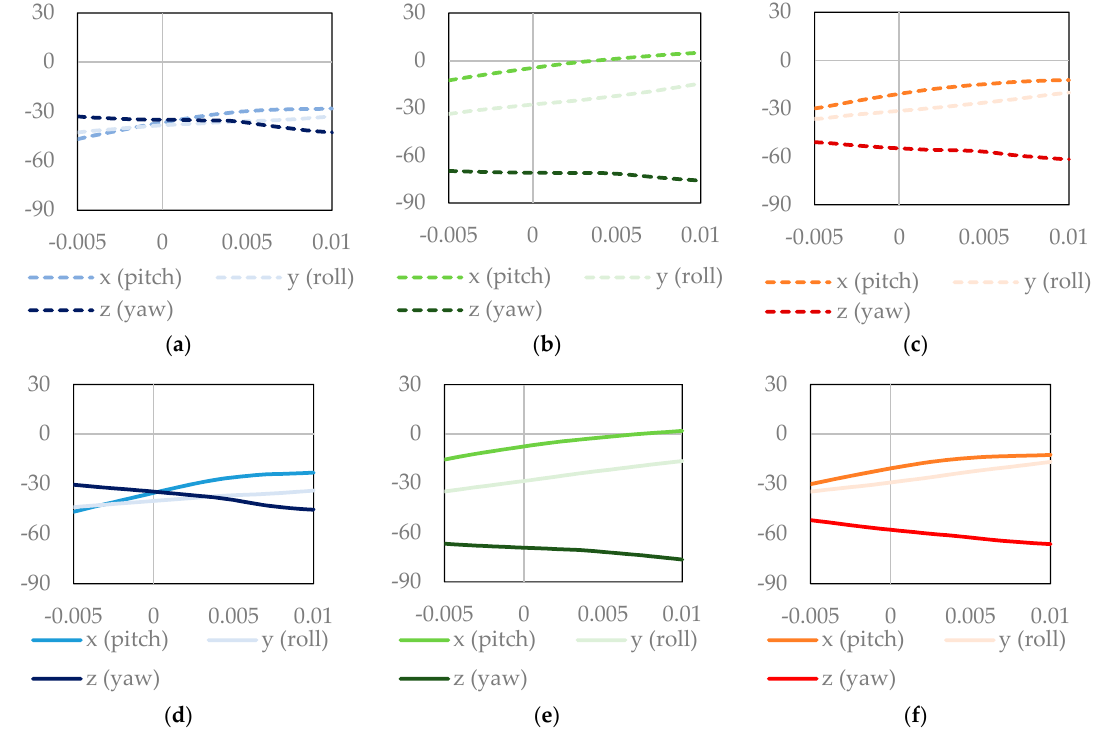
Figure 3. Euler angles ([degree]: vertical axis) of the mean transition value of all participants, expressed with time ([s]: horizontal axis) from the impact: the result of the straight ( a ), curve ( b ) and knuckle ( c ) kicks in the pre experiment; the result of straight ( d ), curve ( e ) and knuckle ( f ) kicks in the post